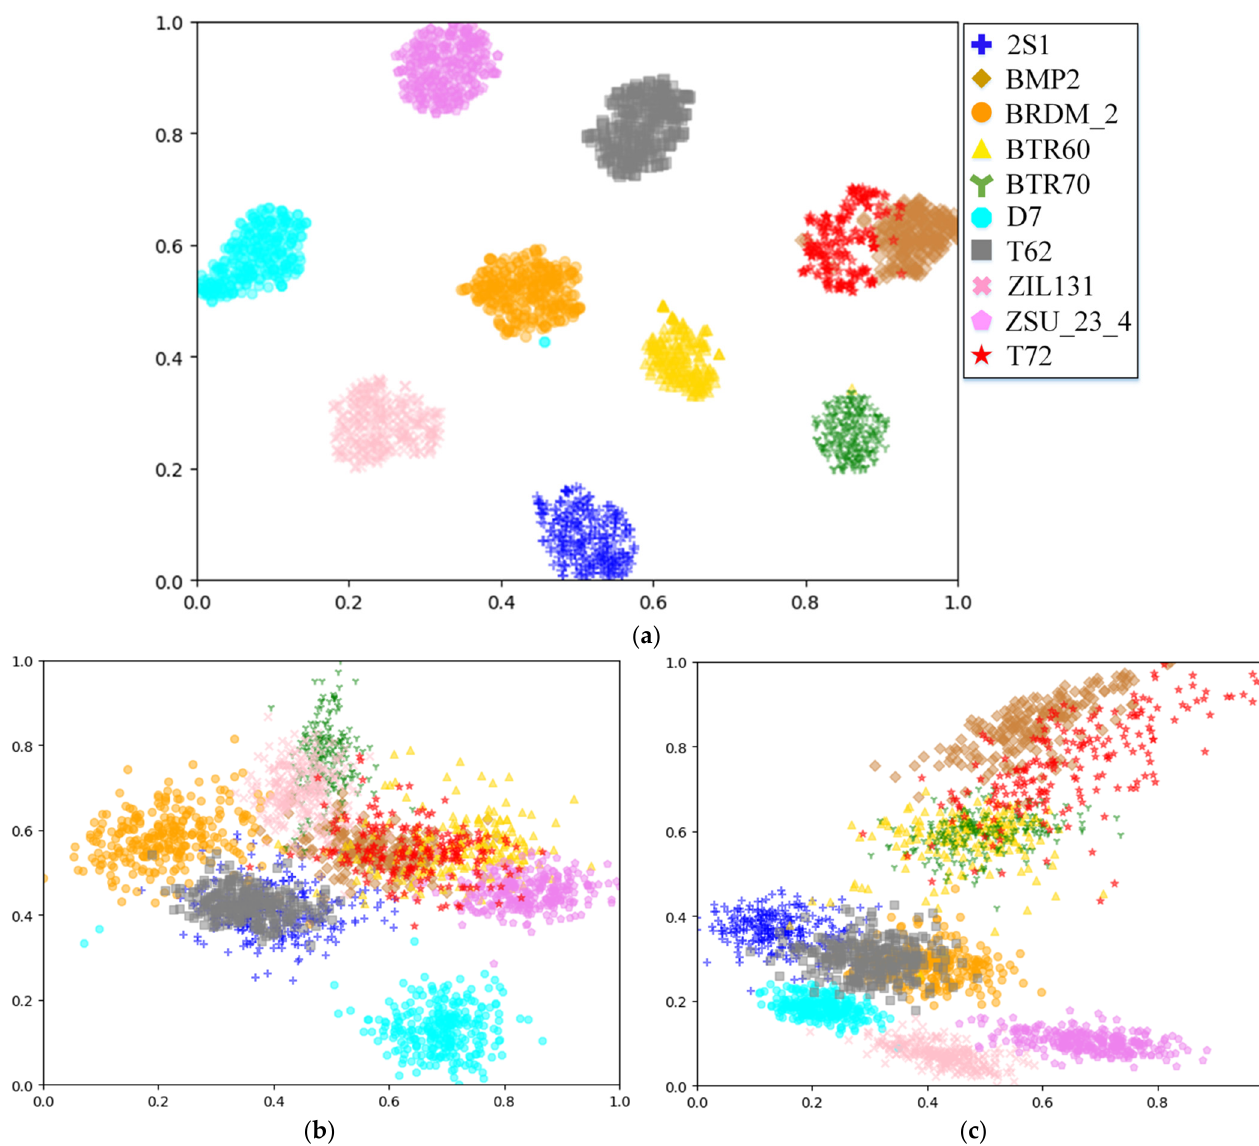
Figure 8. Visualizations of 2425 targets from the Testing Set in 10-type dataset. ( a ) Visualization by t-SNE; ( b ) visualization by RP; ( c ) visualization by PCA. The horizontal and vertical axes represent the target feature in the two-dimensional space after the t-SNE dimensionality reduction in the high dimensional feature